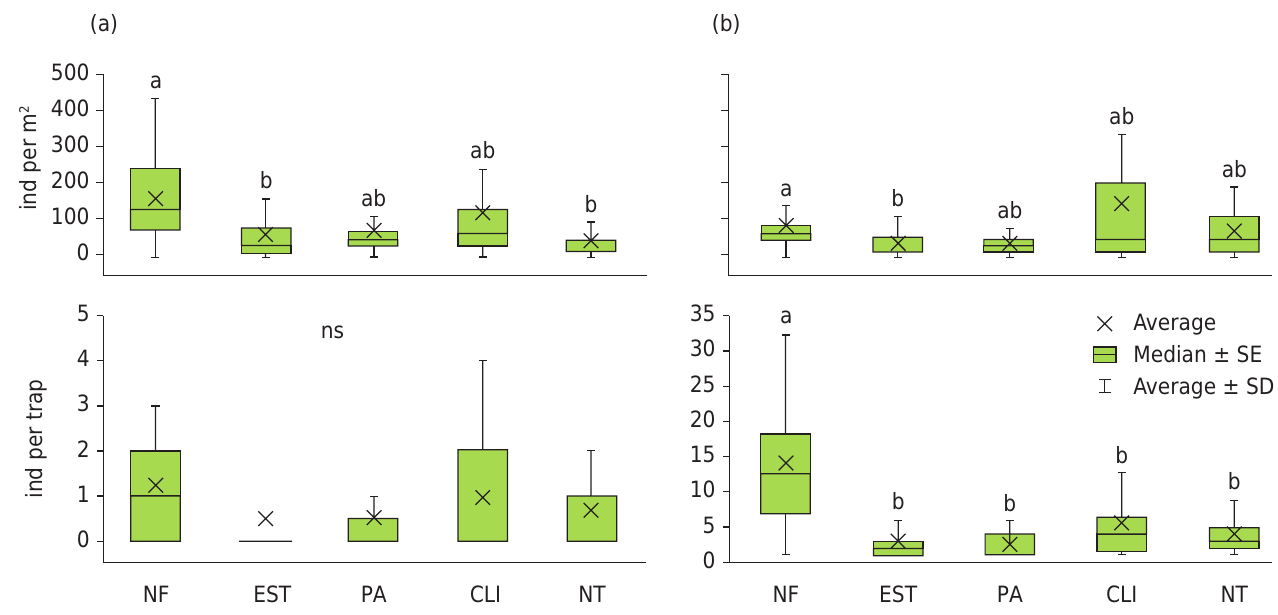
Figure 1. Coleoptera density (ind per m 2 ) and abundance (ind per trap) in native forest (NF), Eucalyptus stands (EST), perennial pasture (PA), crop-livestock integration (CLI), and no-tillage (NT) in winter (a) and summer (b) on the Southern Santa Catarina Plateau. Mean values followed by the same letter are similar by the Kruskal-Wallis test (p<0.05; n = 135); ns: non-significant